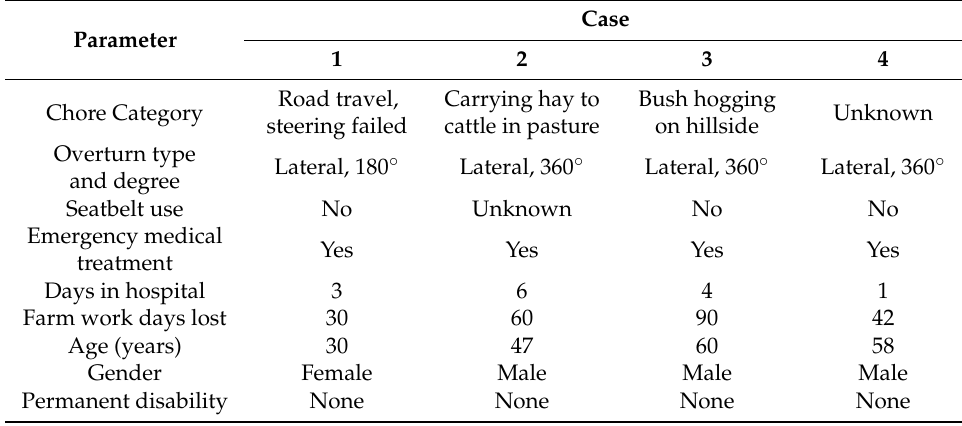
Table 7. Chore category, overturn type, injury outcome, and operator age and gender for overturns of four ROPS-equipped